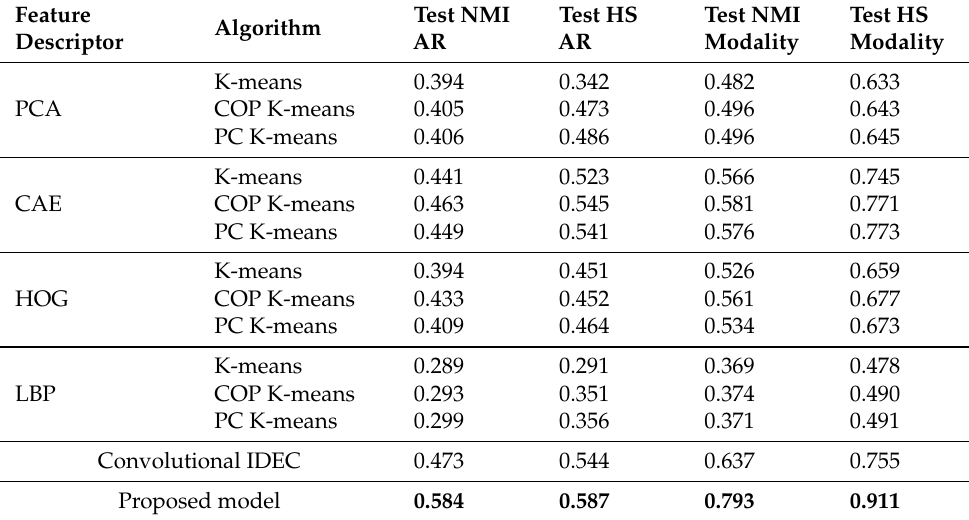
Table 3. Performance of the proposed model against unsupervised k-means, unsupervised convo- lutional IDEC, semi-supervised COP k-means, and PC k-means, using several feature descriptors. For semi-supervised models, 2000 constraints were used. The proposed model is trained using the following hyperparameter values: α = 0.1, β = 1 and γ = 10. The results shown represent the mean obtained from 10 independent iteration runs. Best results are